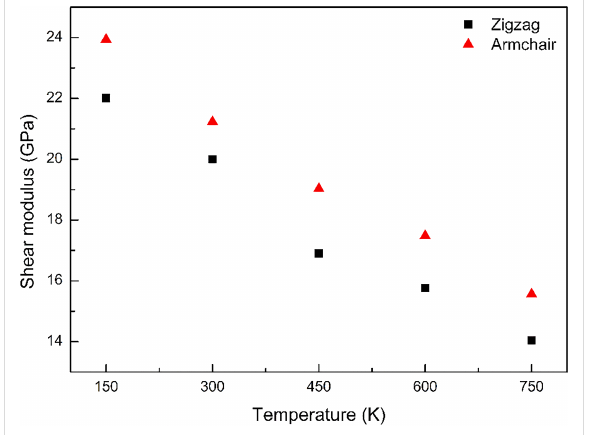
Figure 4: The shear modulus of GPCuNL composites at different tem- peratures and with different graphene